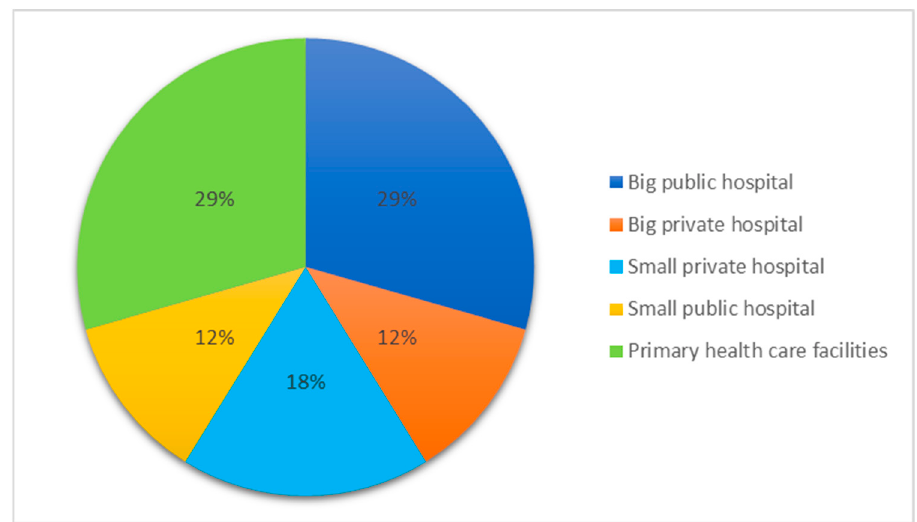
Figure 1. Distribution of health facilities assessed by the participants included in the